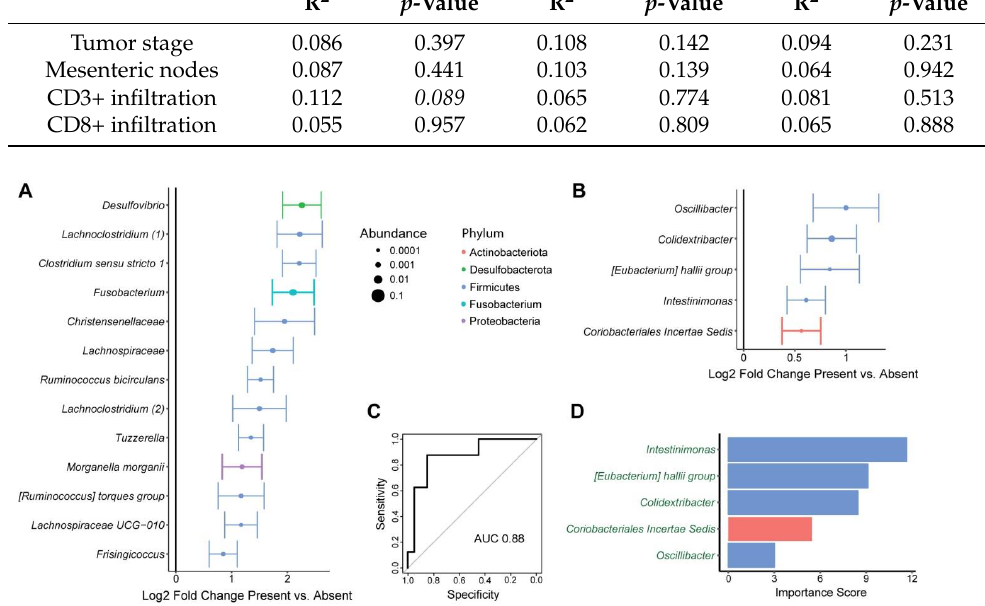
Figure 2. Tissue and fecal microbes are associated with mesenteric lymph node involvement by tumor. ( A ) ASVs that were differentially abundant between tissue from subjects with presence or absence of mesenteric lymph node involvement are shown. This was based upon multivariate models incorporating sample site as a covariate and subject as a random effect. Log2 fold change ± standard error is shown, with dot size proportional to mean relative abundance of the ASV. Color represents phylum. ( B ) ASVs that were differentially abundant in the feces of subjects with pres- ence or absence of mesenteric lymph node involvement. ( C , D ) Random forests classifiers predict- ing mesenteric lymph node involvement based upon fecal microbiota. ( C ) Classifier performance is shown by a receiver operating characteristic curve with the indicated area under the curve (AUC). ( D ) Microbes included in the classifier are shown with their importance scores, which reflect con- tribution of the microbes to classifier accuracy. Names are colored in green to indicate that the mi- crobes were enriched in subjects with mesenteric lymph node involvement. 3.3. Tumor T Cell Infiltration Is Associated with Tumor and Fecal Microbiota To investigate T cell infiltration into tumor, slides of the tumor core were obtained from pathology specimens surgically removed from patients. Immunohistochemistry was performed to stain for CD3 (a marker of all T cells) and CD8 (a marker of cytotoxic T cells) and the number of infiltrating T cells was quantified (Figure 3). T cell infiltration data were available for 25 subjects, who were divided into low or high T cell infiltration based upon previously published cutoffs that predicted prognosis for patients with lo- cally advanced CRC [21]. In some cases, rectal cancer patients receiving radiation pre-operatively had inadequate remaining tumor tissue for this analysis to be performed. Tissue microbiota overall composition, but not alpha diversity, showed a significant association with CD3+ T cell and CD8+ T cell infiltration ( p = 0.015, p = 0.009, respectively) (Tables 2 and 3). Differential abundance testing demonstrated significant enrichment of a single ASV, annotated as Blautia faecis, in tissue samples from subjects with high CD3+ T cell infiltration (log2FC 1.91). There were no differentially abundant taxa at the genus or phylum levels with CD3+ T cell infiltration. To investigate whether specific tissue sites would show stronger association with CD3+ T cell infiltration, we performed beta diver- sity analysis for each site separately. There was a trend towards an association of CD3+ T cell infiltration with microbial composition in the tumor core ( p = 0.089) but not the other sites (Table 4). Tumor core was biologically plausible as having the strongest microbiome association since T cell infiltration was measured in the tumor core. We therefore as- sessed for differential abundance of microbes in tumor core tissue in high vs. low CD3+ T cell infiltration. Nine ASVs were enriched in tumor core in subjects with high vs. low CD3+ T cell infiltration, including two members of the Blautia genus, two members of the